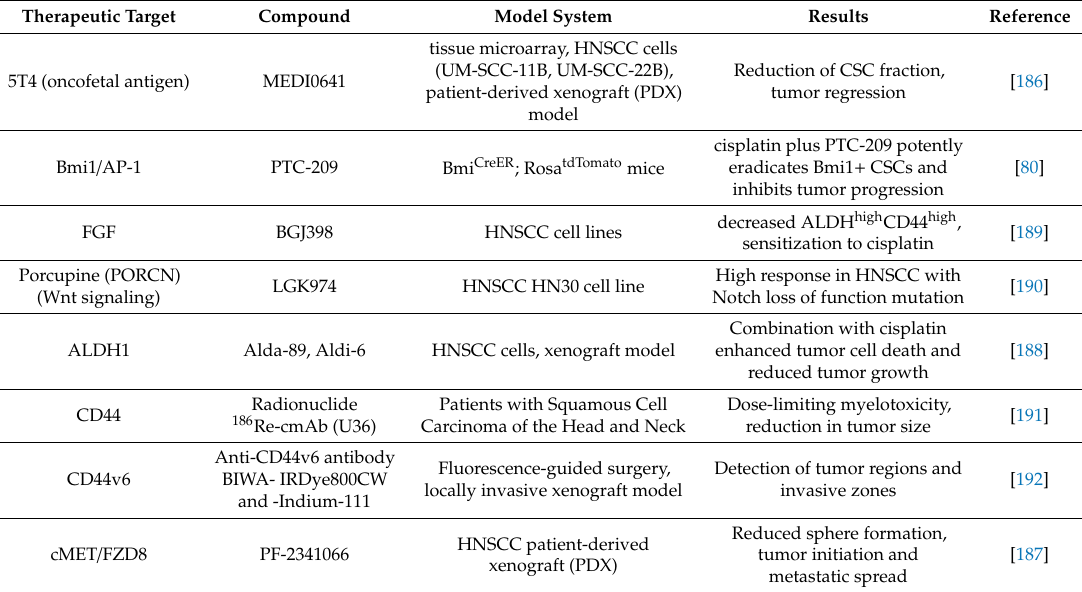
Table 3. CSC-targeting approaches in HNSCC